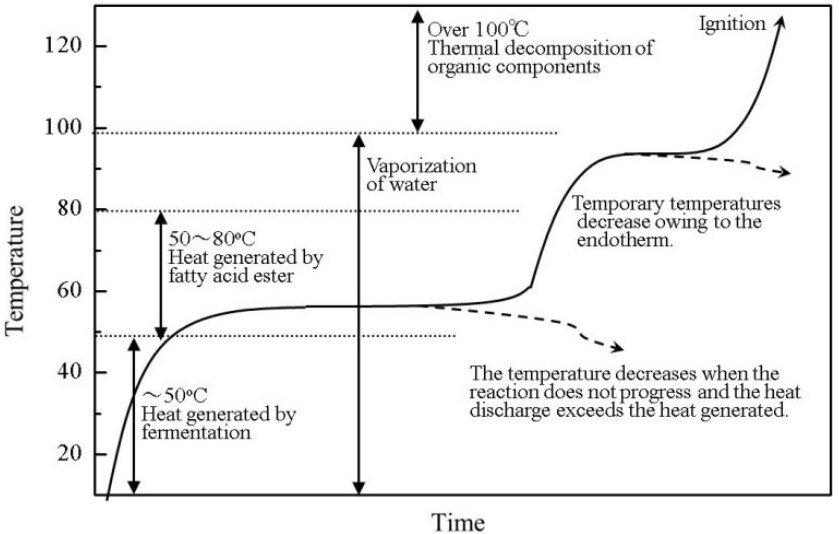
Figure 16. Combustion mechanism of biomass